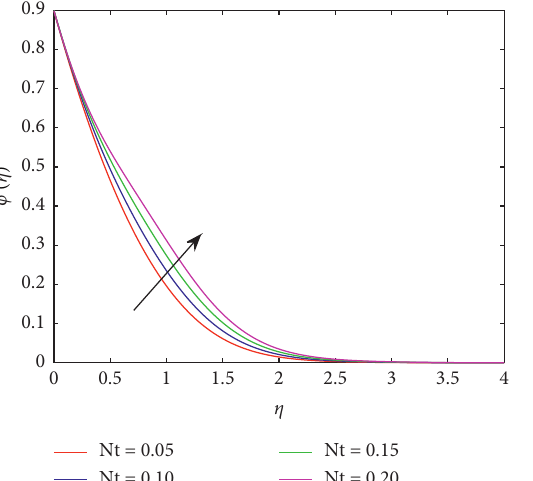
Figure 18: Variation due to Nt in ϕ ( η ) .